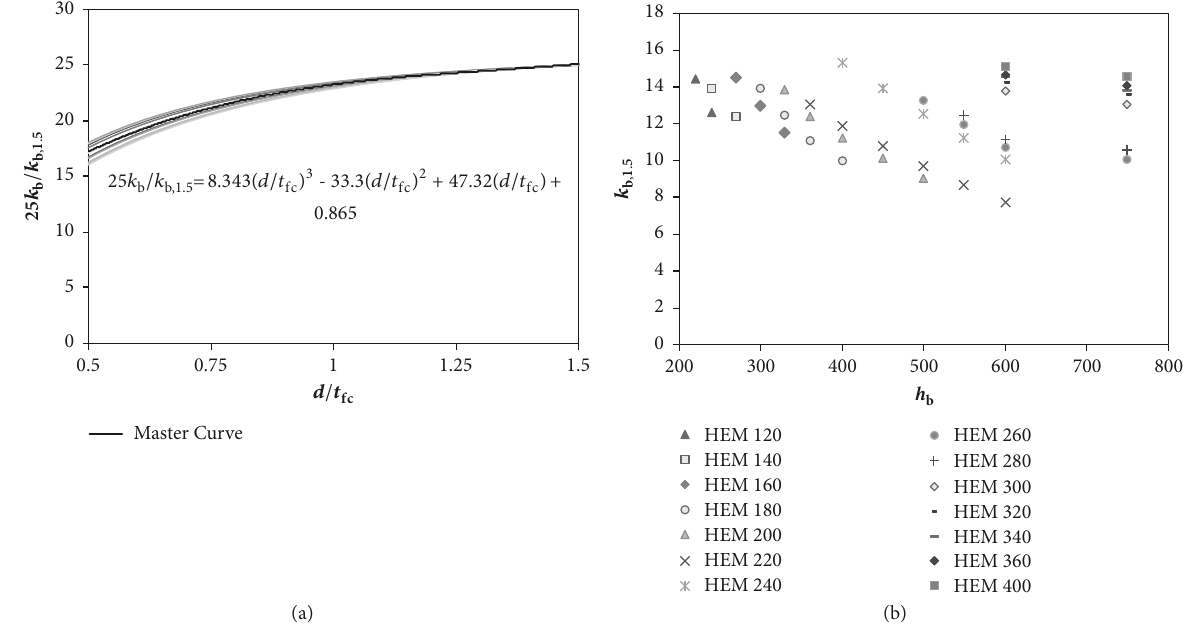
Figure 7: 25𝑘 b /𝑘 b ,1.5 versus 𝑑/𝑡 fc relationship (a) and the curve shifting factor 𝑘 b ,1.5 (b).